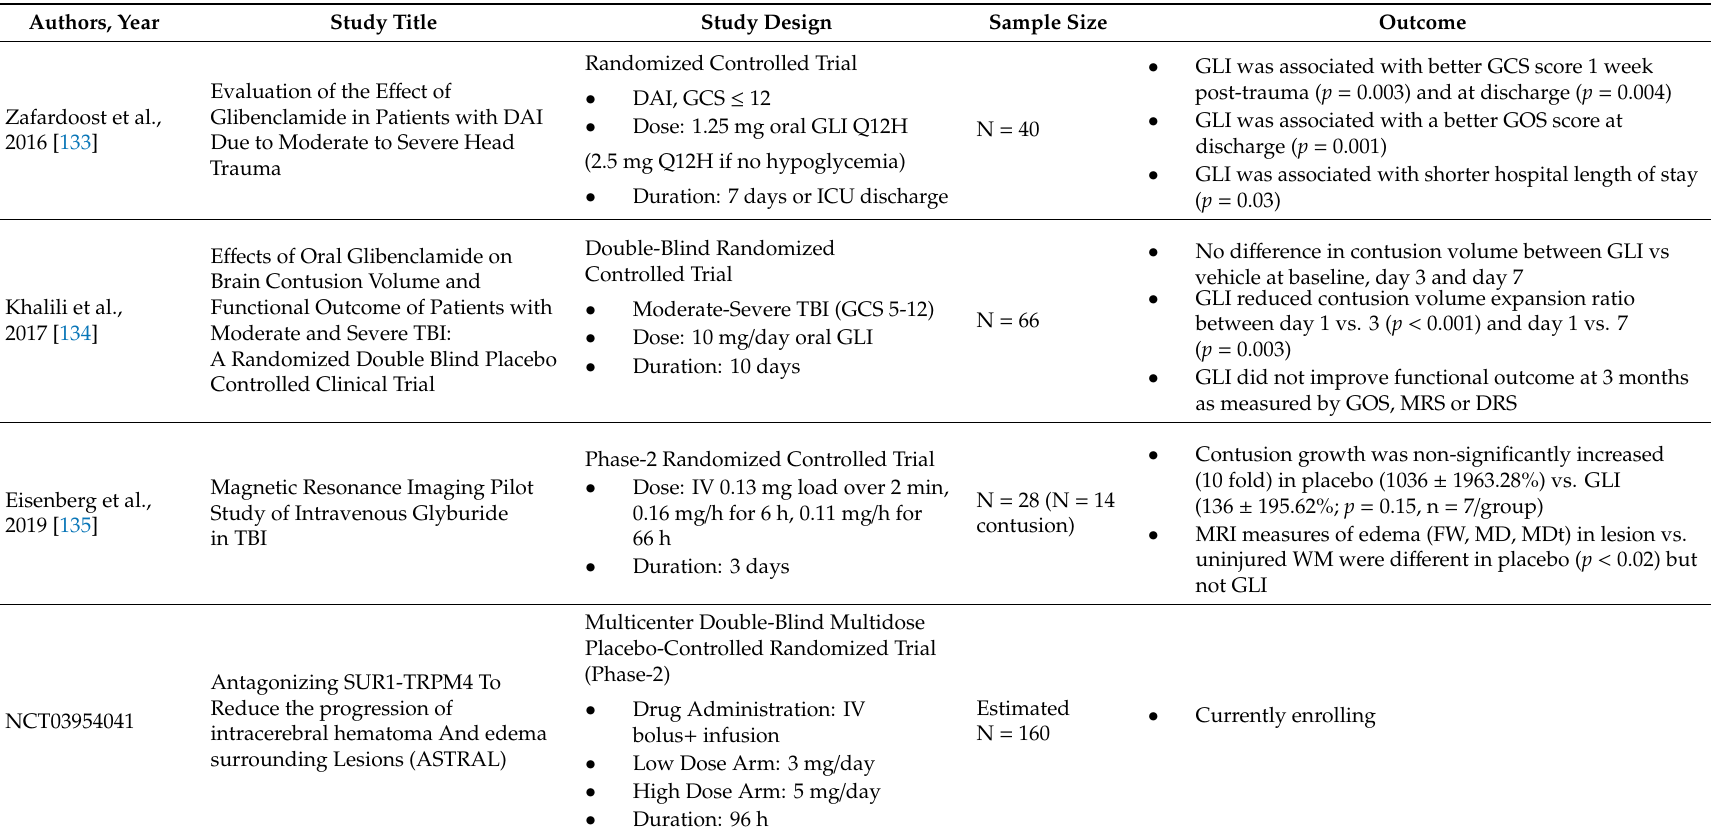
Table 3. Clinical Studies of Glibenclamide in TBI (Chronologically